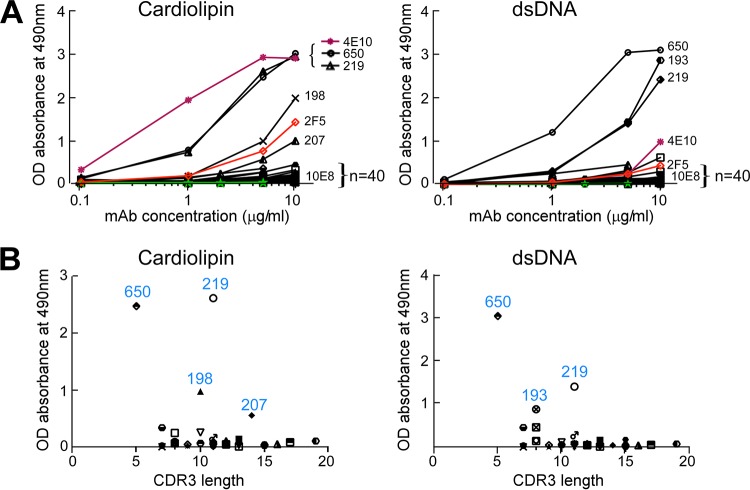
Low frequencies of autoreactivity and polyreactivity of MPER-specific Abs elicited by immunization with various MPER/liposome vaccines. (A) Forty-four different MPER-specific rMAbs from mice immunized with liposome vaccines containing Npalm-MPER, the Npalm-W680A mutant, or Cpalm-MPER were tested for autoreactivity and polyreactivity by cardiolipin and dsDNA ELISAs and were compared with anti-MPER BNAbs (red, 2F5; purple, 4E10; and green, 10E8). Data shown are representative of three independent experiments. (B) Lack of correlation between reactivities and CDRH3 lengths among the 44 different Abs tested in panel A. The y axis represents the absorbance at 490 nm of bound antibodies from panel A at 5 μg/ml, plotted against CDRH3 length on the x axis.